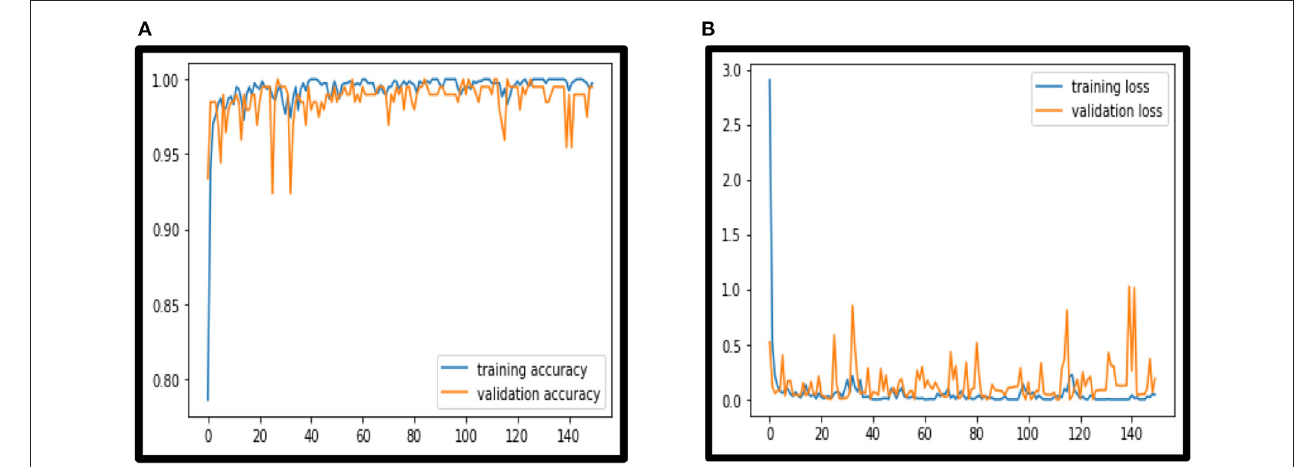
FIGURE 11 | (A) VCNet accuracy. (B) VCNet loss.